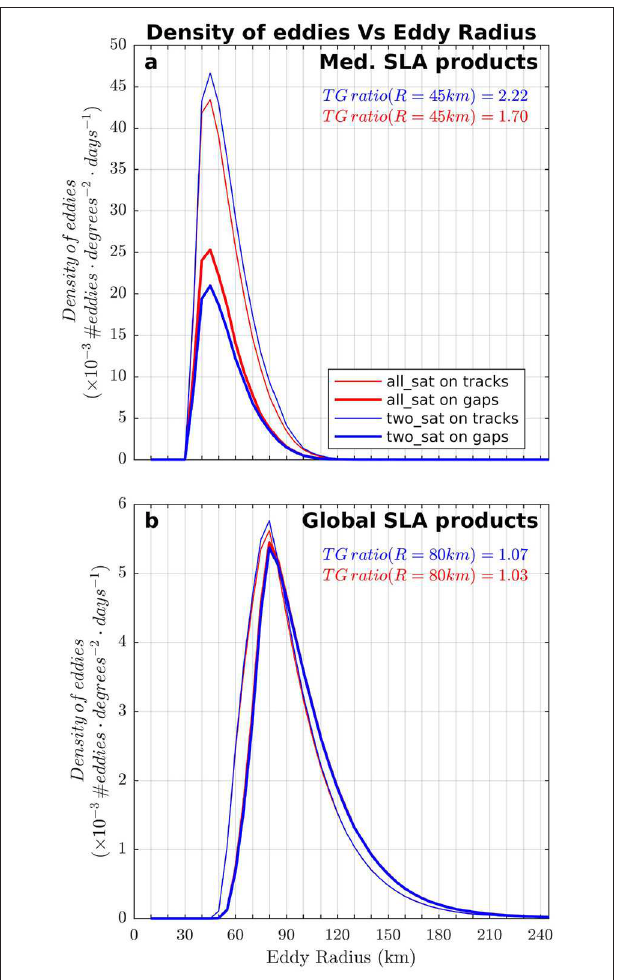
FIGURE 3 | (a) Eddy density on a 0.5 ◦ strip along the Topex/Poseidon tracks (thin lines) and in the gaps between the tracks (thick lines) for the Mediterranean Sea all satellites SLA product (red lines) and the two satellites SLA product (blue lines) as a function of eddy radius (computed as the radius of a circle with the same area of the eddy) for the 23 years of daily SLA maps. (b) Same as (a) but for the global SLA products distributed by Copernicus and for the whole global ocean.